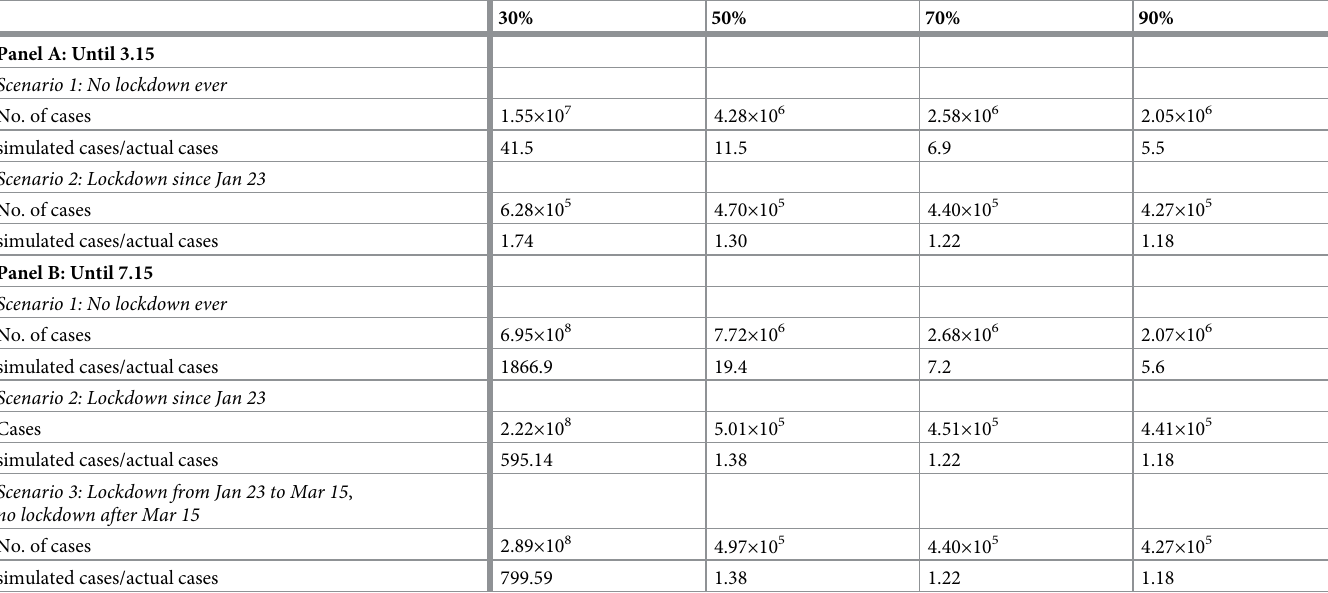
Table 3. Alternative scenario with different testing